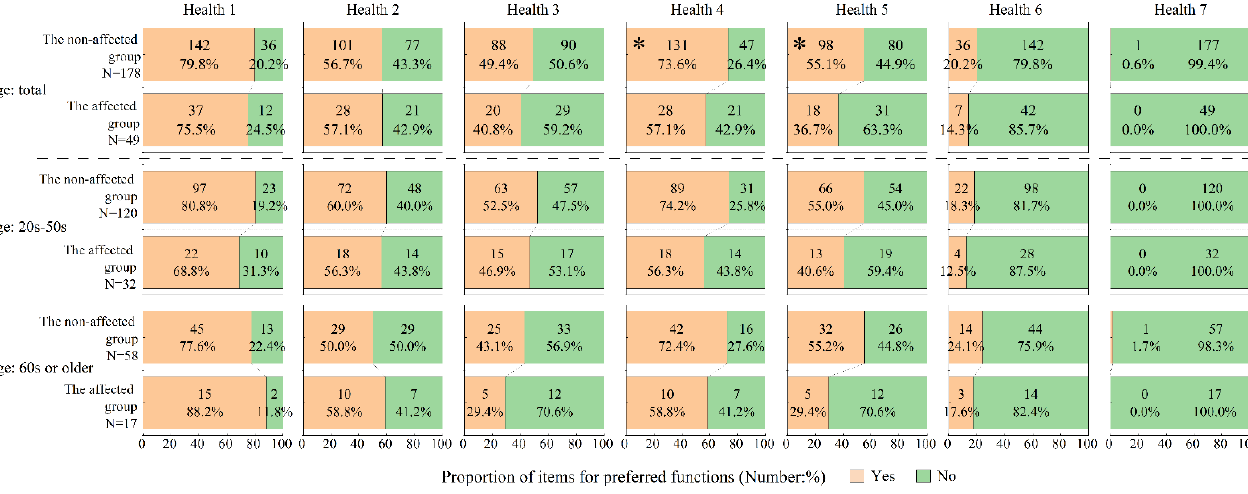
Figure 3. Preferred functions of health-related applications. a . a Subjects interested in health-related applications were asked to select functions that they preferred. Preferences for application functions were as follows: Health (1) Measure health parameters (e.g., weight, blood pressure, and blood sugar), Health (2) Collect physical activity data (e.g., number of steps), Health (3) Collect information on your mental health/well-being through a questionnaire, Health (4) Provide general information on the effect of radiation on health and protection measures, Health (5) Provide specific advice and instructions related to your personal situation and health status and/or well-being, Health (6) Provide some degree of interactivity (questions/answers/live chat), and Health (7) Others. Asterisk (*) indicates p < 0.05.